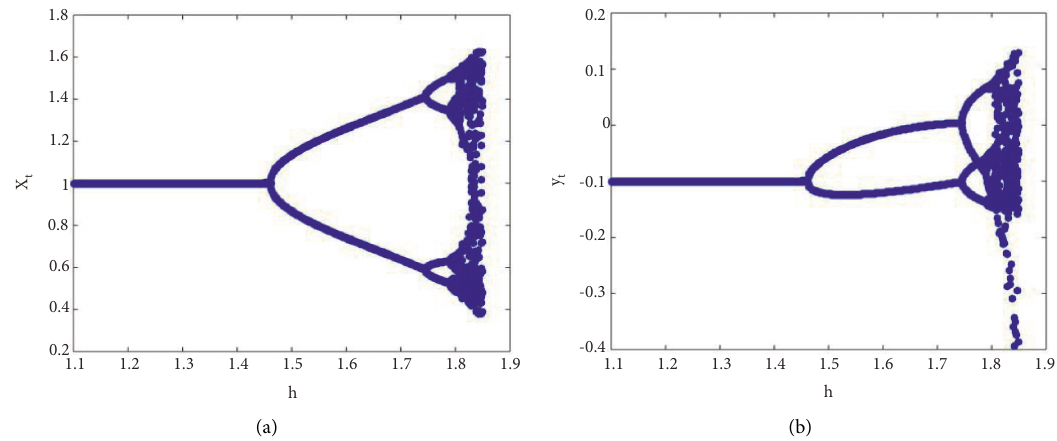
Figure 7: Flip bifurcation diagrams of the Brusselator system (10) with ( 0 . 5 , 0 . 05 ) and h ∈ [ 1 . 1 , 2 . 75 ]